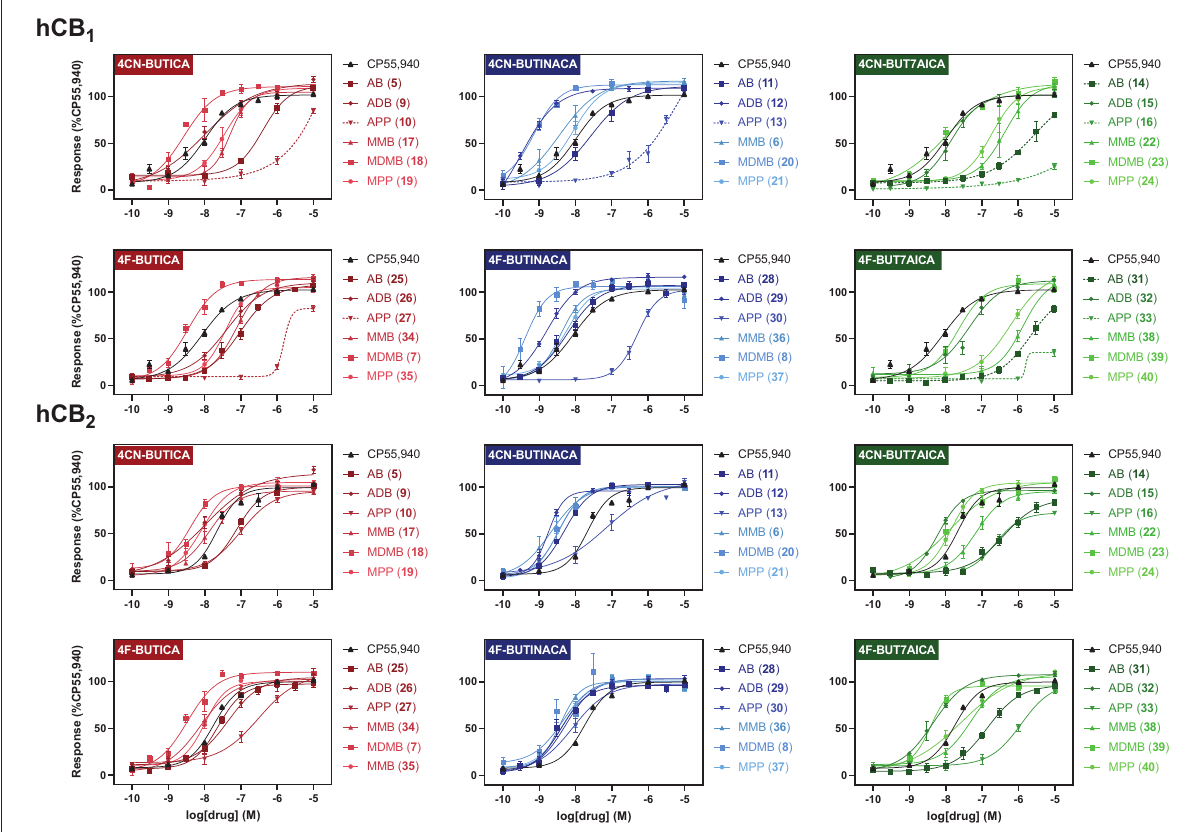
FIGURE4 Functional activities of compounds 5–40 at hCB 1 and hCB 2 , relative to CP55,940. Efficacies are normalised to maximal response of 1 µ M CP55,940. Vertical sets indicate the same heterocyclic core (left = indole; centre = indazole; right = 7-azaindole). Graphs are grouped by tail, with rows indicating alkyl tails, either 4-cyanobutyl (rows 1 and 3), or 4-fluorobutyl (rows 2 and 4). Dashed lines indicate where curve could not be fit. Data is expressed as means ± SEM from 3 to 6 independent